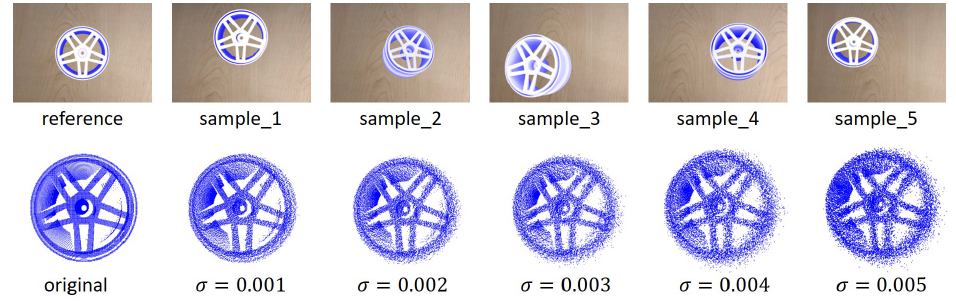
Figure 11. The upper row is the rendered images with 5 different camera viewpoints. The lower row is the depth data with different standard deviations σ from 0 to